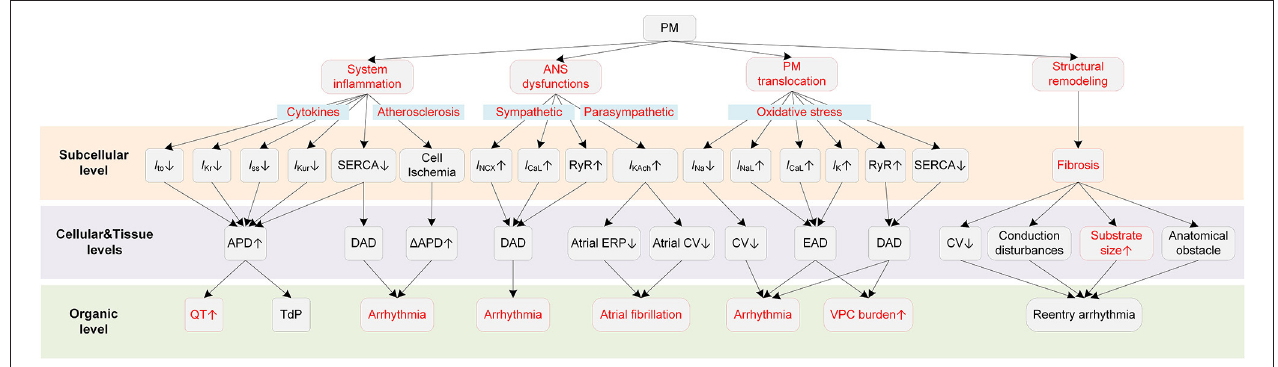
FIGURE 2 | Potential mechanisms underlying PM-induced arrhythmias. Red boxes indicate effects of PM that have been explicitly demonstrated.